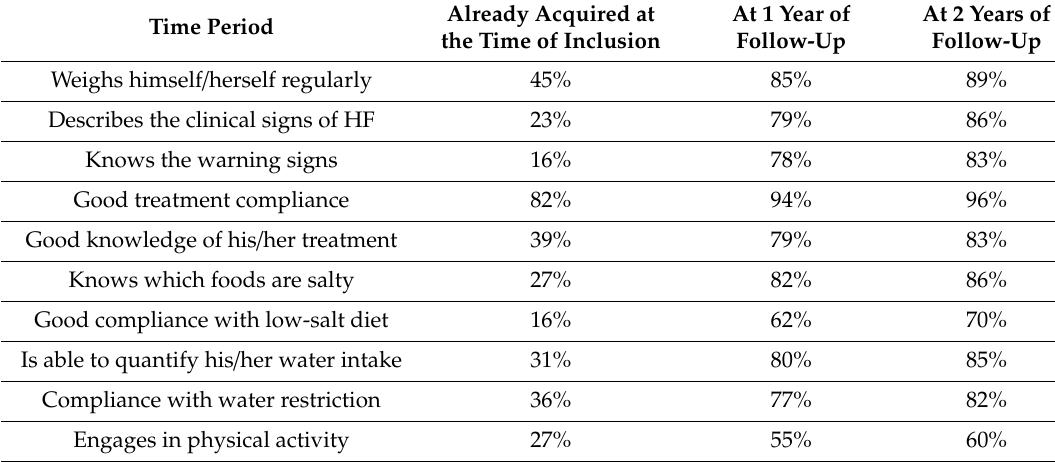
Table 4. Data pertaining to the knowledge of patients about heart failure before and after inclusion in the USICAR ( Unit é de Suivi des Patients Insu ffi sants Cardiaques )